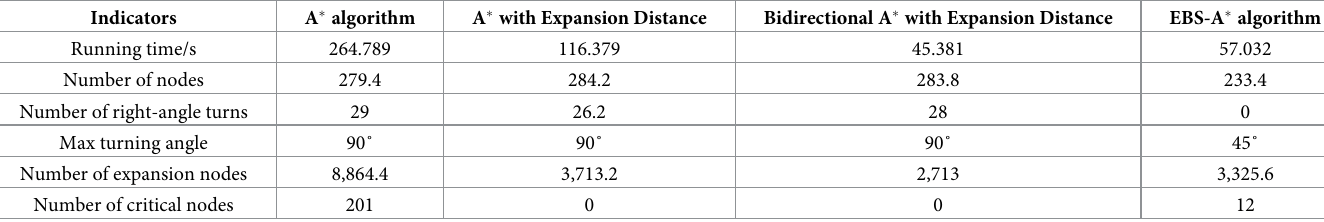
Table 6. Average simulation results of four algorithms on randomized 150 × 150